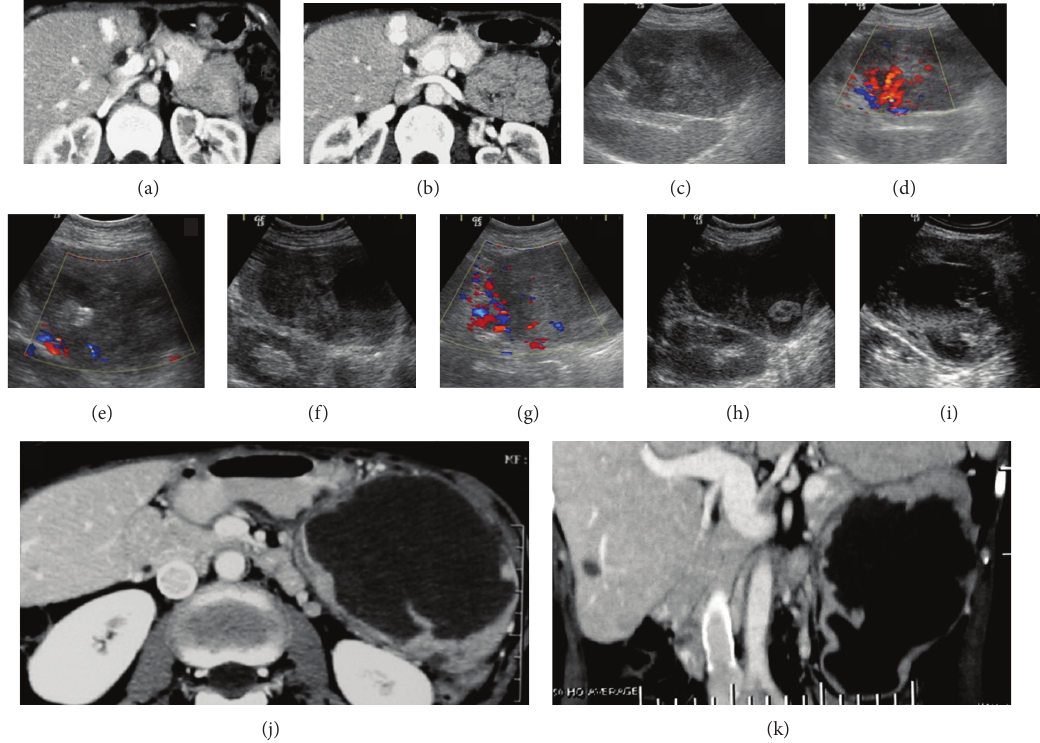
Figure 2: A 44-year-old woman with about 9.3 × 8.4 × 8.7 cm metastatic pancreatic tail carcinoma. The pre-HIFU enhanced CT (a) showed low-density lesions in pancreatic tail with clear boundary, internal heterogeneous echo, small liquefaction necrosis, and internal inhomogeneous enhancement (b). Ultrasound (c) showed a hypoechoic pancreatic tail with a clear boundary, internal heterogeneous ultrasound reflection, and oval anechoic area. The CDFI (d) showed a rich blood flow signal in tumor parenchyma. In the 5th treatment, ultrasound showed air-like hyperechoic reflection within tumor parenchyma; CDFI showed significant decrease of blood flow signal in tumor parenchyma (e). In the 8th treatment, liquefaction necrosis area increased, liquefied surface formed through necrotic material deposition (f), and blood flow signal decreased significantly in tumor parenchyma (g). In 12th (h) and 17th (i) treatments, tumor parenchyma decreased while liquefaction necrosis inside significantly increased with floating pellets or tablets of necrotic materials. A month later, the axial (j) and coronal (k) enhanced CT showed significant tumor volume increase with internal large liquefaction necrosis, a little marginal parenchyma and tumor ablation ration over